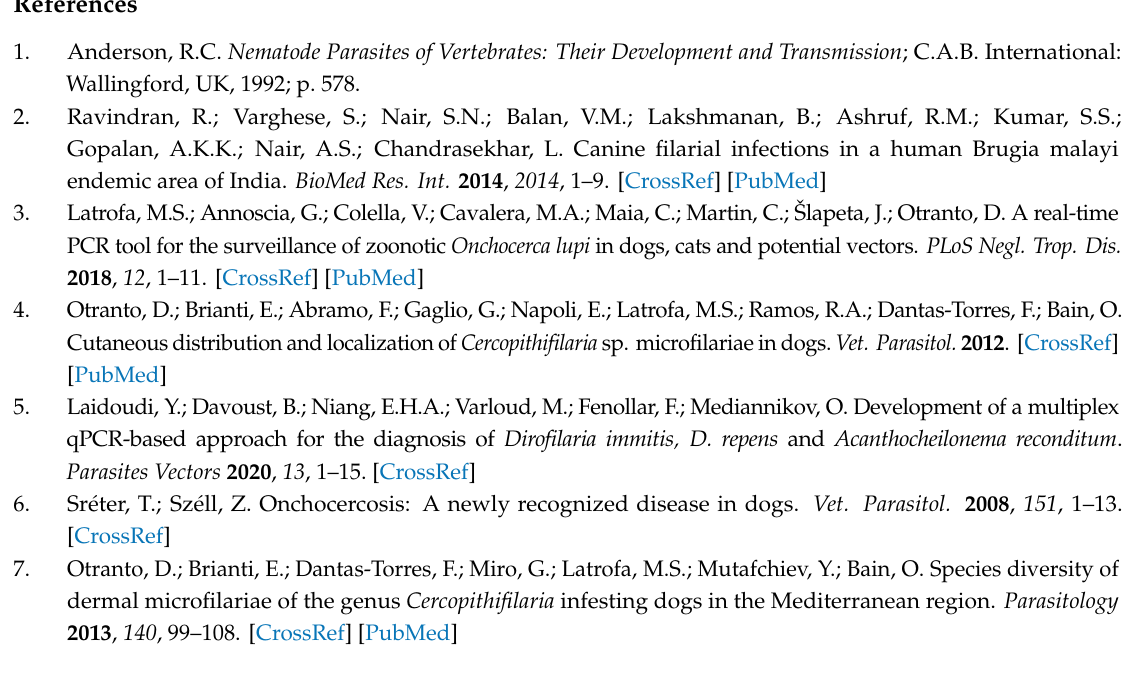
s1. Table S1: Negative control DNA used for specificity determination of designed qPCR systems; Table S2: Molecular identification of filarial DNA from positive samples (tick / blood). Figure S1: Analytical sensitivity of the CanFil- C. grassii assay in detecting (a) filarial DNA (i.e., Onchocerca lupi ), (b) Cercopithifilaria grassii and (c) pooled DNA of O. lupi and C. grassii . Figure S2: Analytical sensitivity of the C. bainae-C.sp.II assay in detecting Figure S3: Analytical sensitivity and detection limit of the CanFil- C. grassii assay using a serial 10-fold dilution of single-species-DNA of Dirofilaria immitis microfilariae